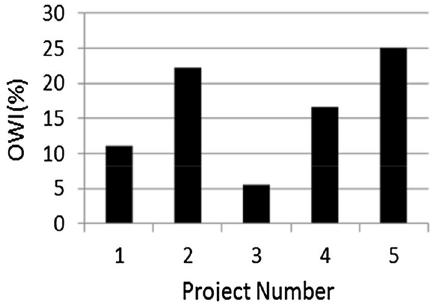
Fig. 7 OWI values (in %) for each of the five projects listed